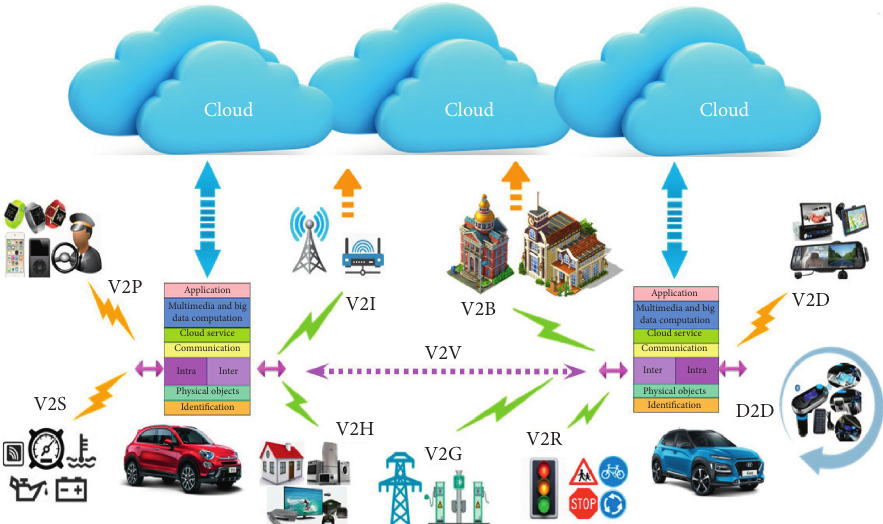
Figure 2: Internet of Vehicles architecture for the smart cities